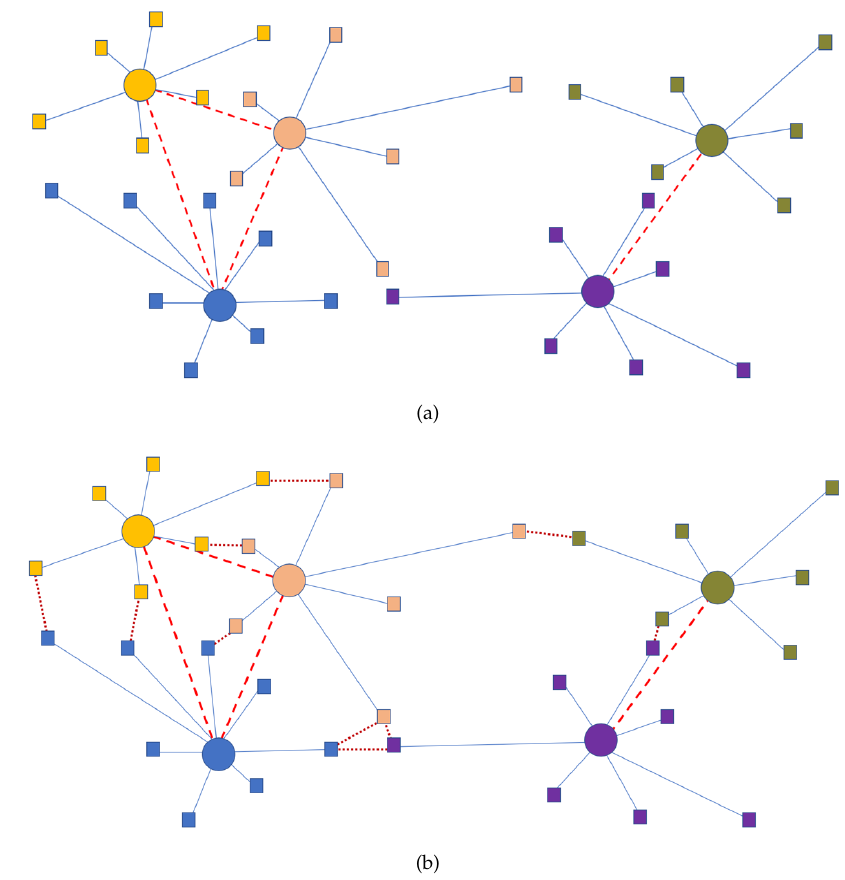
Figure 3. Example of the differences in interferences considered in AIIM and CB-AIIM. ( a ) AIIM. ( b )